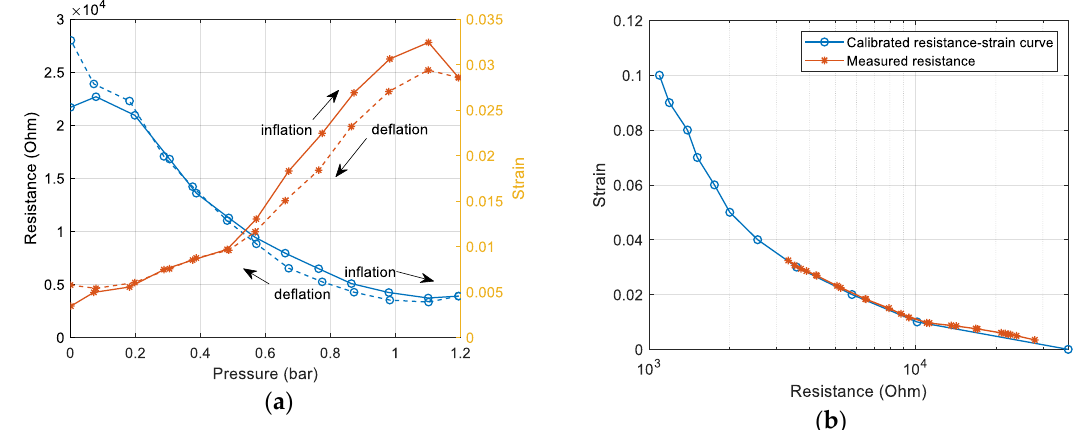
Figure 8. ( a ) Measured real-time resistance and strain against the driven pressure from 0 to 1.2 bar. ( b ) Calibrated resistance–strain relationship (Figure 5) and measured resistance from the self-sensing finger (Figure 8a).